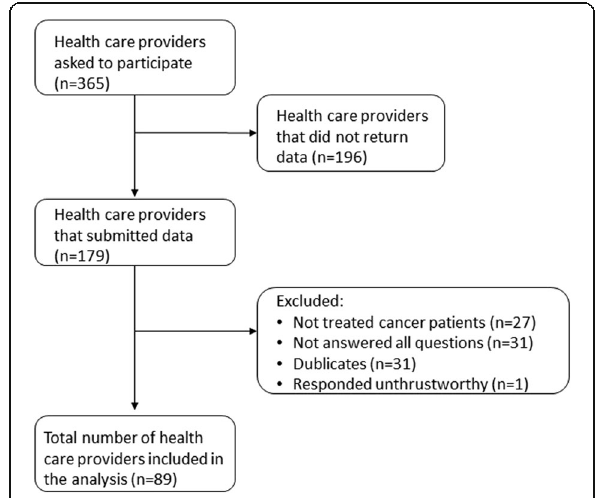
Fig. 2 Flowchart of the inclusion process in the Vanguard Study